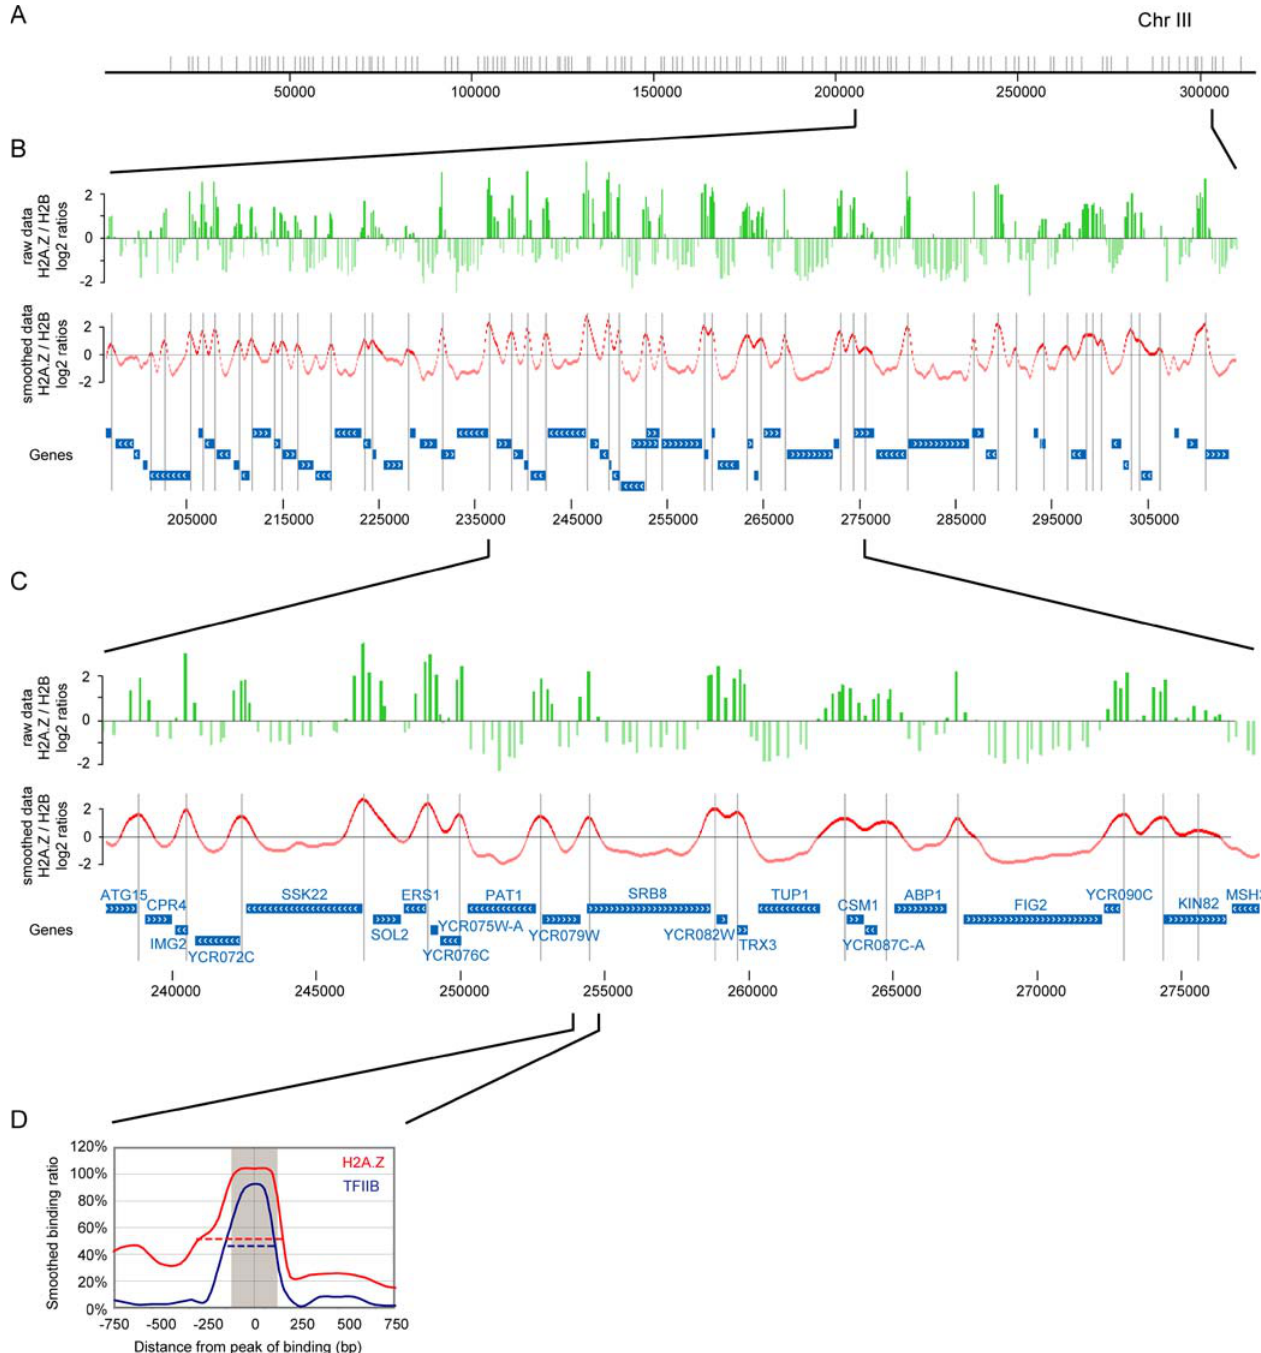
Figure 1. Genome-Wide Location Analysis of H2A.Z and H2A; a Zoom on Chromosome III (A) The location of the Z loci along Chromosome III is depicted by gray bars. (B) A zoom in a 120 KB region between position 196611–316611 shows the raw H2A.Z/H2B log 2 ratios for each probe in that region (green bars) and the smoothed data resulted from the Gaussian plot analysis of the raw data for H2A.Z/H2B log 2 ratios (red line). The position of the Z loci is shown by gray lines. The genes present in that regions are shown in blue. (C) Same as in (B) but for a zoom in region 237700–277700 (40 KB). (D) The size of the Z loci within the promoter of the SRB8 gene as determined by Q-PCR analysis of ChIP experiments. The binding ratios for H2A.Z (red) and TFIIB (blue) are shown relative to the center of the probe that generates the maximum enrichment. The data were smoothed by a sliding median over three probes (see Figure S1). The size of the observed H2A.Z domain is about 250 bp larger than that of TFIIB. Since TFIIB covers about 10 bp of DNA, we can infer that H2A.Z covers about 260 bp of DNA at that locus (shaded area). More details can be found in Protocol S1 and Figure S1. DOI: 10.1371/journal.pbio.0030384.g001